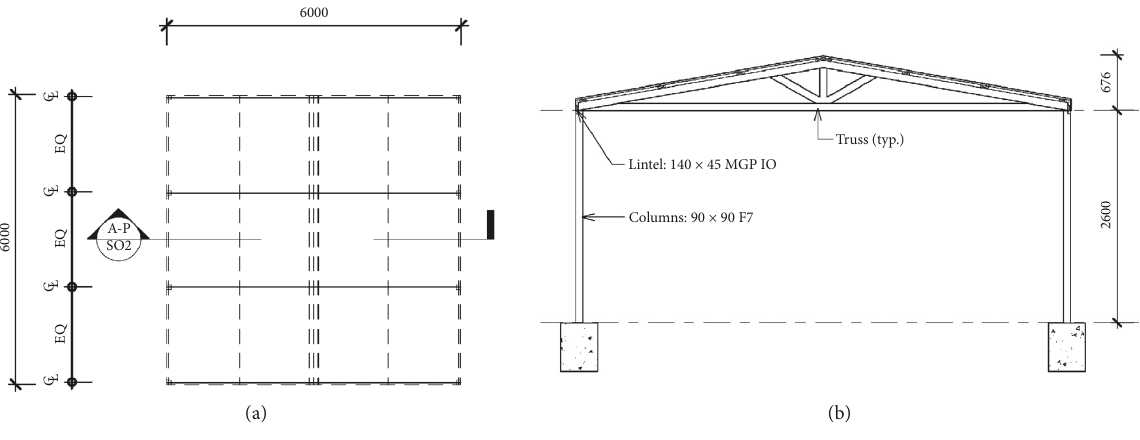
Figure 5: Truss system Case A. (a) Layout. (b) Cross section. Table 5: Summary of truss material costs.